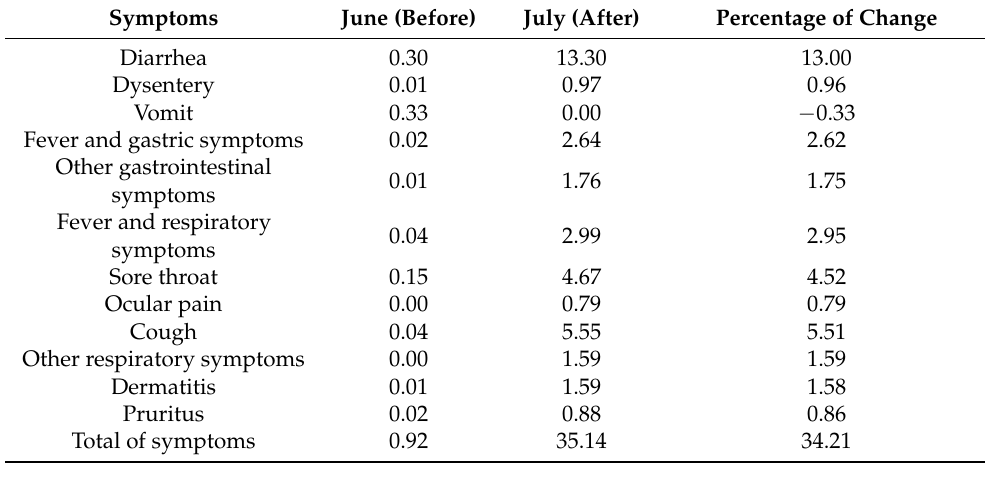
Table 1. Incidence Rate per 100,000 inhabitants of Monterrey, during 2010, of symptoms before and after Hurricane Alex. ( n = 1613 telephone surveys).